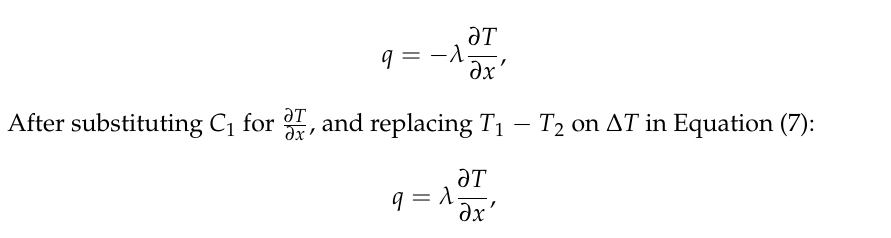
Table 2. Value of temperature gradient in films containing filler ZnO ( ∆ T 1 ) and in films without filler ( ∆ T 2 ), as well as the numerical ratio of the thermal conductivity coefficient ( T , ◦